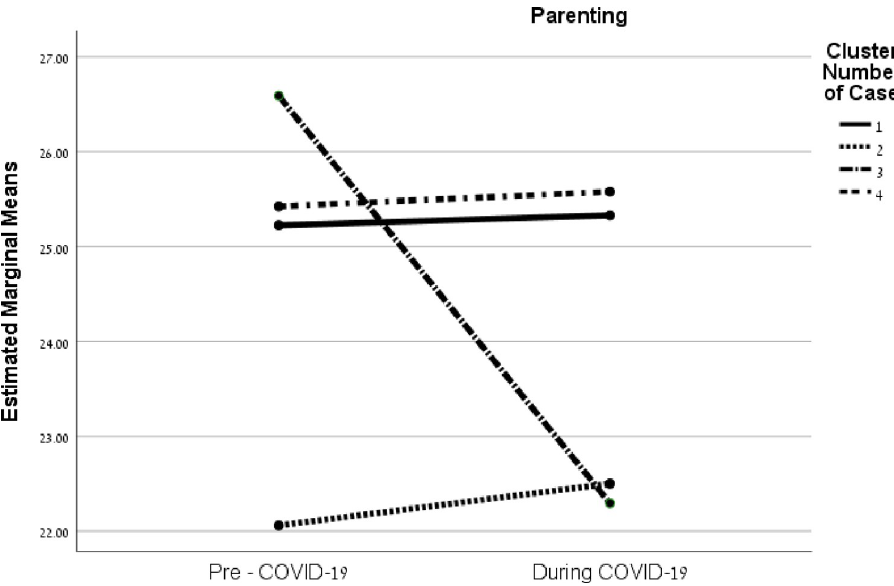
Fig 3. Interactions between coping strategies of families and before/during the COVID-19 crisis on family quality of life factors.